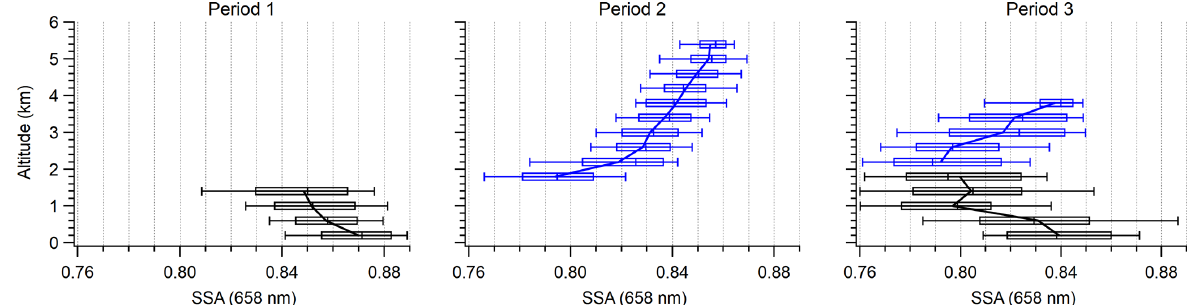
Figure 7. The vertical distribution of SSA at 658nm in the BB-polluted FT (blue) and BL (black) respectively for each period. The box-and- whisker plots represent the 10th percentile, 25th percentile, median, 75th percentile and 90th percentile in every 400m bin. The lines are the trend of average values in every 400m